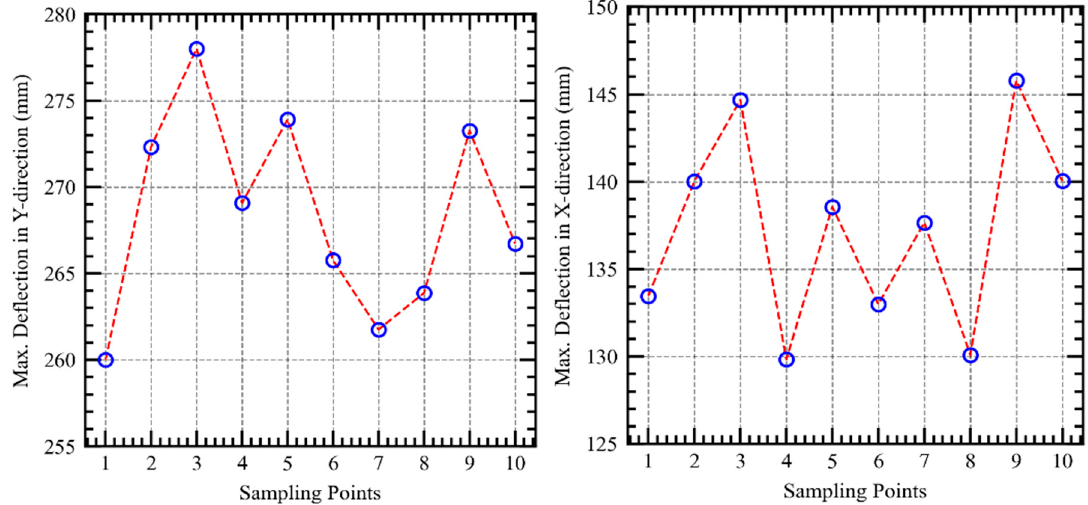
Figure 16. Maximum top structural deflection.